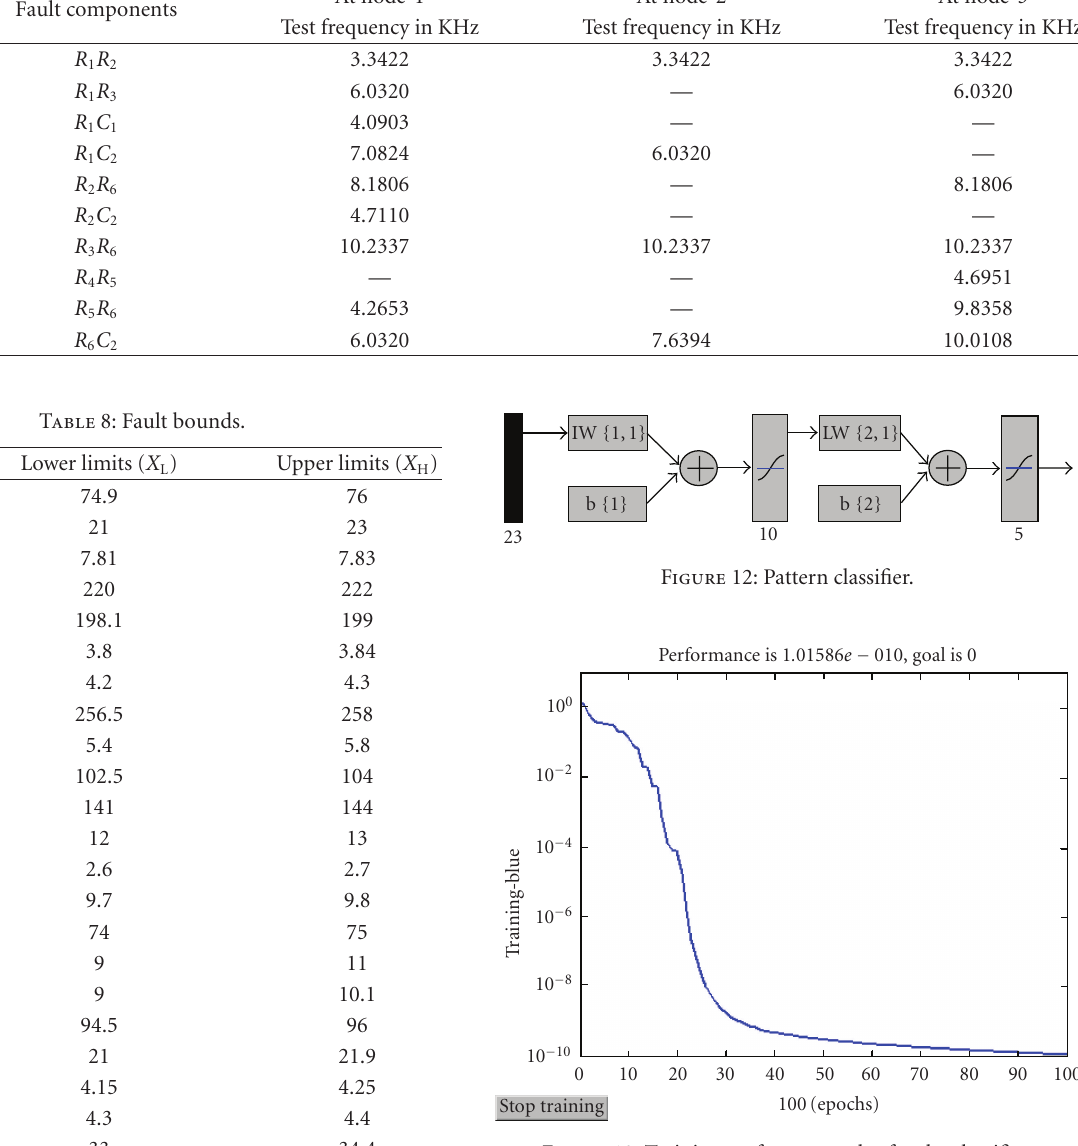
Figure 13: Training performance plot for the classifier.